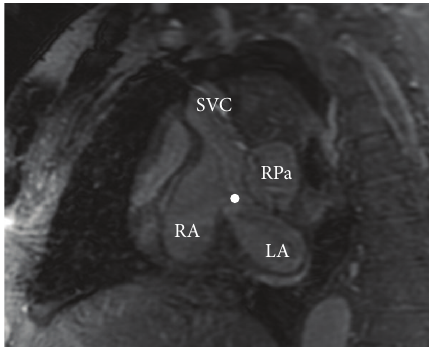
Figure 2: Sagittal 3-dimensional steady state free precession (SSFP) magnetic resonance image demonstrating a large sinus venosus defect (circle). SVC: superior vena cava; RPa: right pulmonary artery; RA: right atrium; LA: left